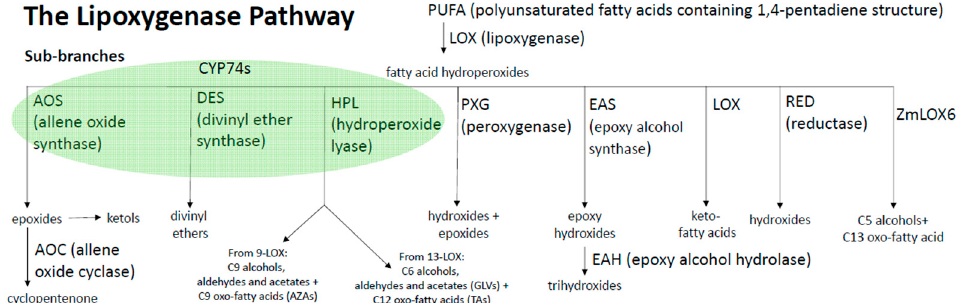
Figure 3. Major metabolite classes produced by the eight sub-branches in the Lipoxygenase (LOX) pathway. LOXs catalyze the dioxygenation of polyunsaturated fatty acids (PUFA), namely linoleic (C18:2) or linolenic (C18:3) fatty acids at the 9- or 13-carbon position. The subsequent hydroperoxide